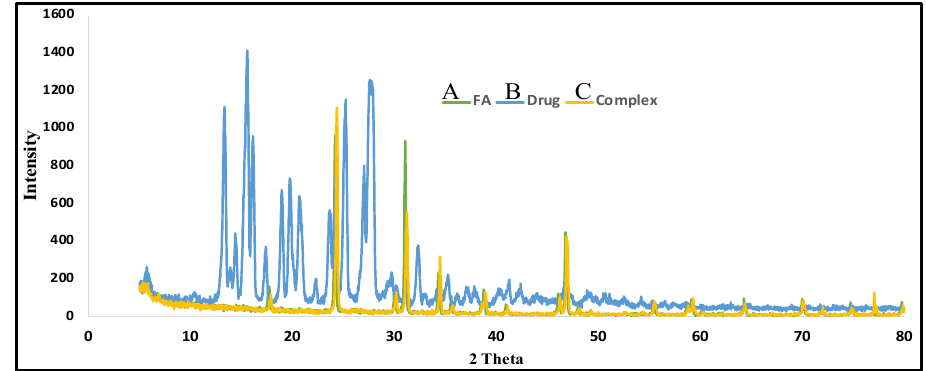
Figure 4. Overlay of X-ray diffractograms of A (FA), B (CBZ), and C (CBZ-FA complex).